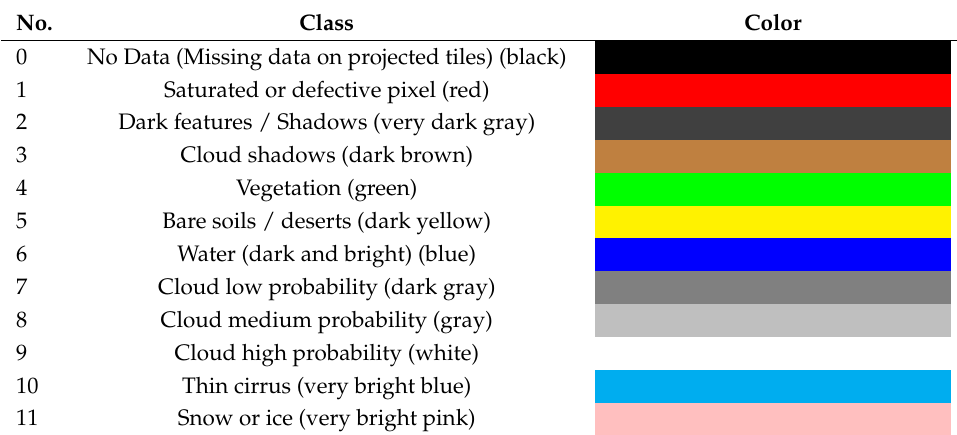
Table 1. List of Sen2Cor Scene Classification Classes and Corresponding Colors